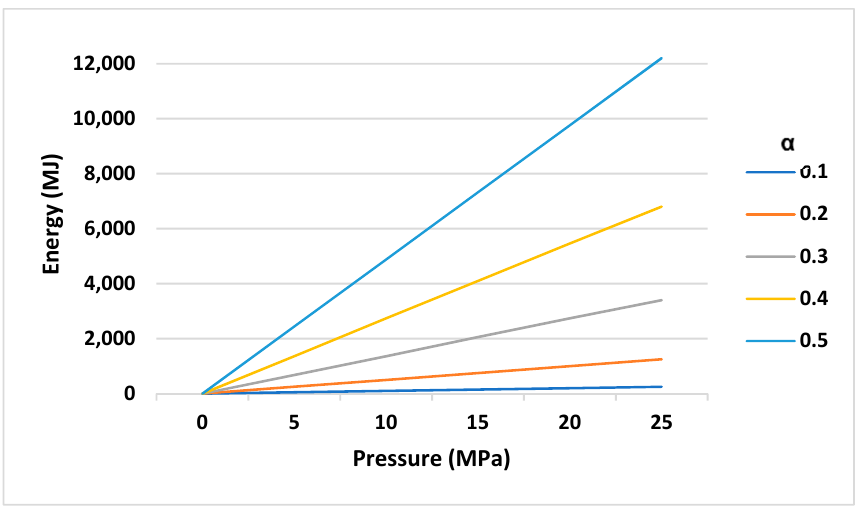
Figure 19. Changes in saved energy compared to pressure for different values of α and tank volume of 1000 m 3 ).